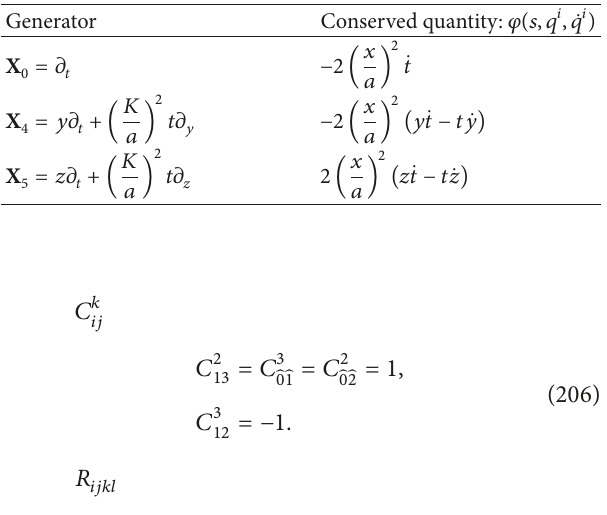
Table 29: Conserved quantities corresponding to each Noether symmetry.